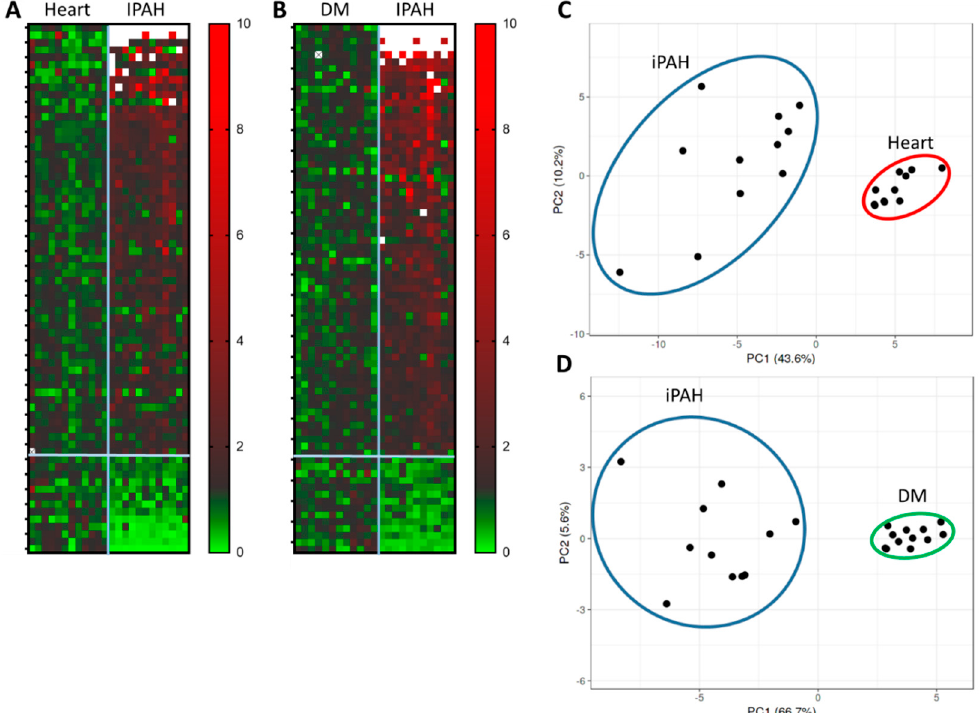
Figure 1. Metabolic profiling of plasma of pulmonary arterial hypertension (PAH) patients ( n = 11), and comparison with diabetes mellitus (DM; n = 12) and left heart disease (heart; n = 11) patients. Our data indicate significantly ( p < 0.05) altered metabolites in PAH vs. heart and PAH vs. DM analysis. ( A , B ) Heat maps and ( C , D ) principal component analysis (PCA) show the clustering of the PAH group that could differentiate PAH patients from DM and heart by circulating metabolites. Ellipses indicate the area of a 0.95 probability that the metabolic profiling of the patient from the same group will be inside an ellipse.